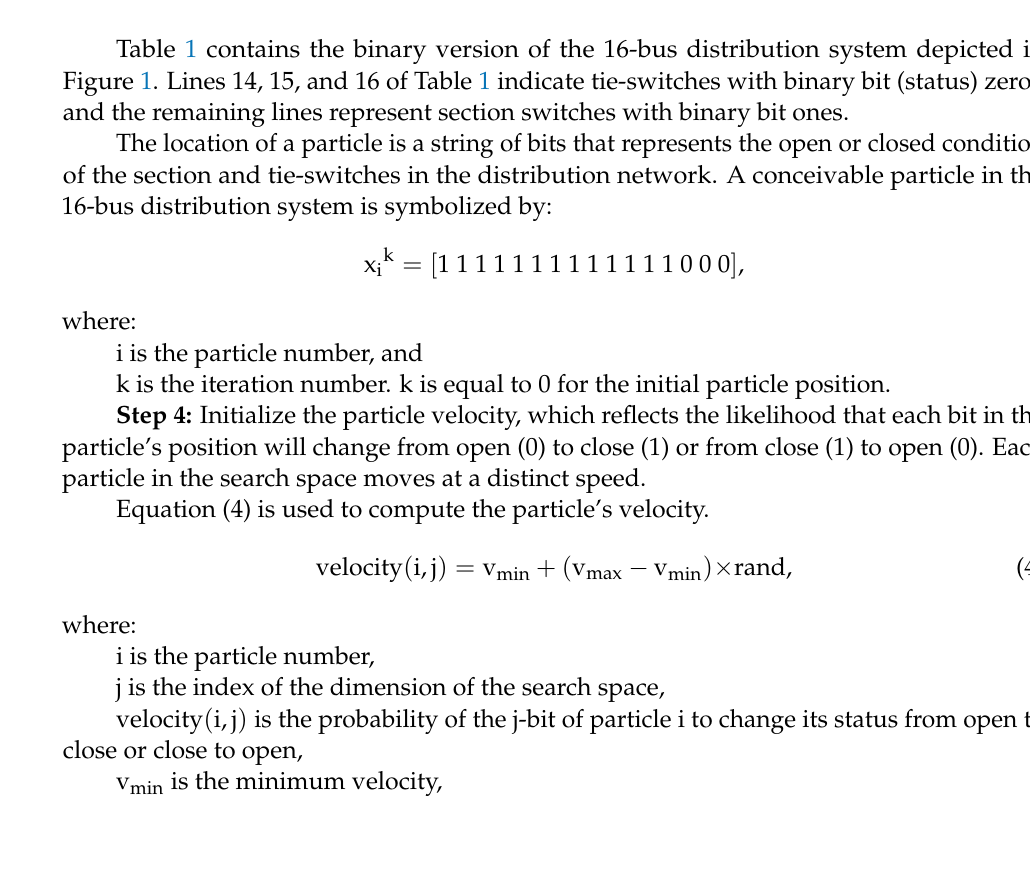
Figure 1. Lines 14, 15, and 16 of Table 1 indicate tie-switches with binary bit (status) zeros, and the remaining lines represent section switches with binary bit